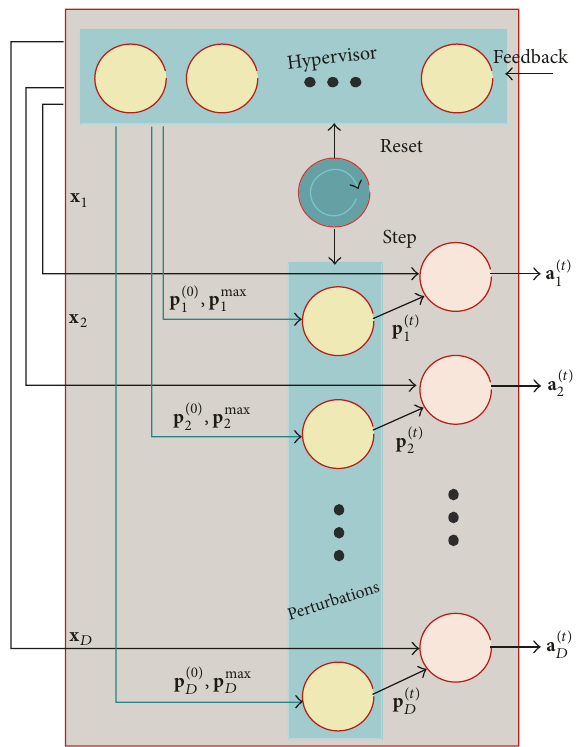
Figure 2: Neural network inspired formulation of an SDN cell. The cell includes a timer neuron, hypervisor neurons, perturbation neurons, and output neurons providing activation at each time step 𝑡